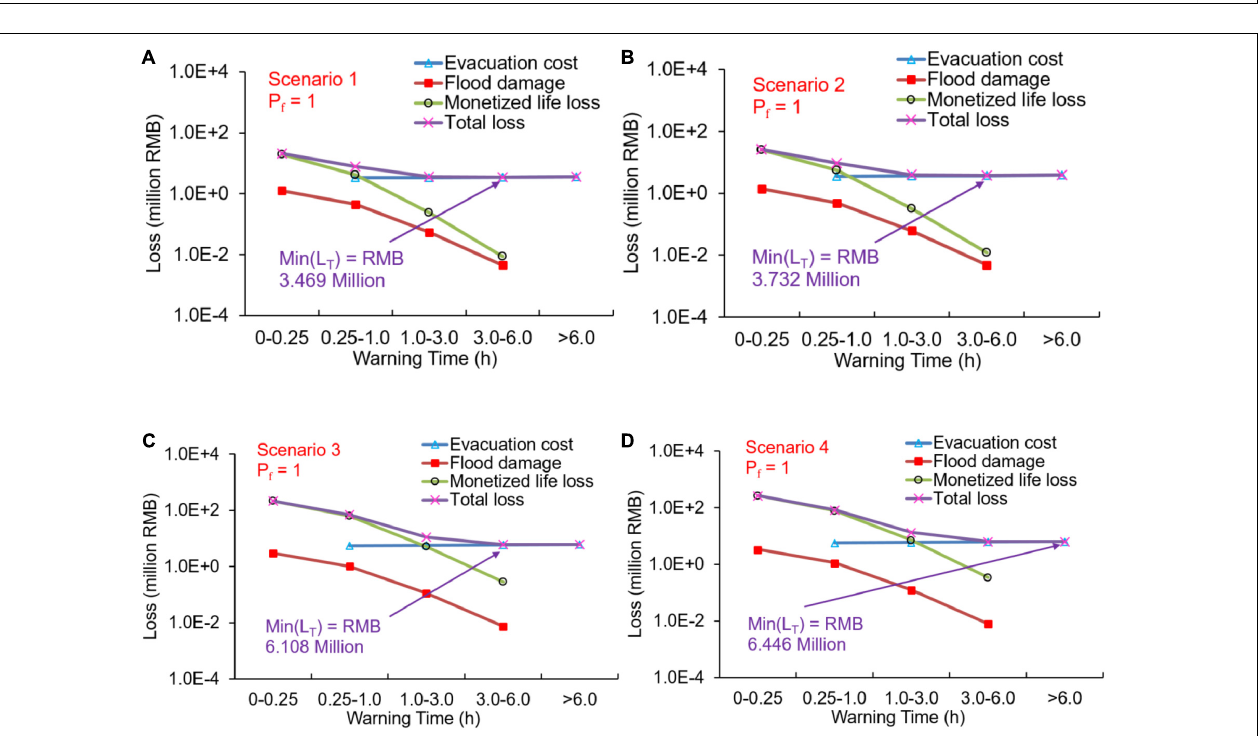
FIGURE 9 | Three types of losses and the expected total loss ( L T ) vary with warning time in the four scenarios when the dam failure probability ( P f ) is 1.0: (A) Scenario 1, (B) Scenario 2, (C) Scenario 3, and (D) Scenario 4.